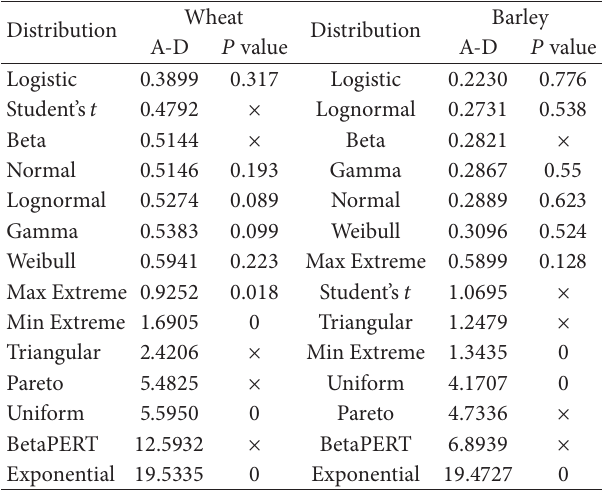
Table 5: The structure of specific-event contracts and the efficiency assessment.